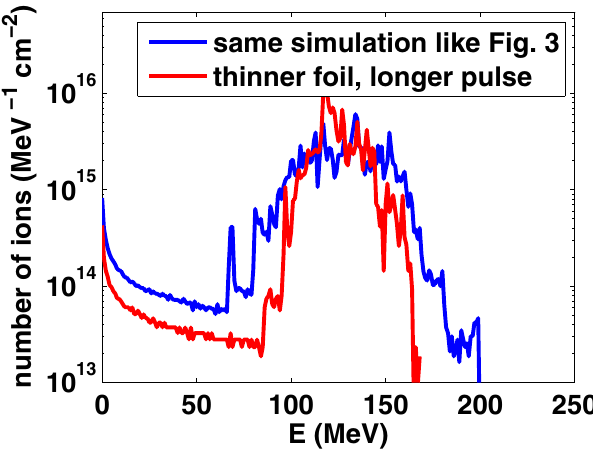
FIG. 5. (Color) Energy distributions of ions at the end of the laser foil interaction. The wider distribution (blue) corresponds to the simulation parameters given in Fig. 3, the narrower distribution (red) corresponds to the simulation where the foil is 2 times thinner and 2 times denser and the laser pulse is 2 times longer and 2 times less